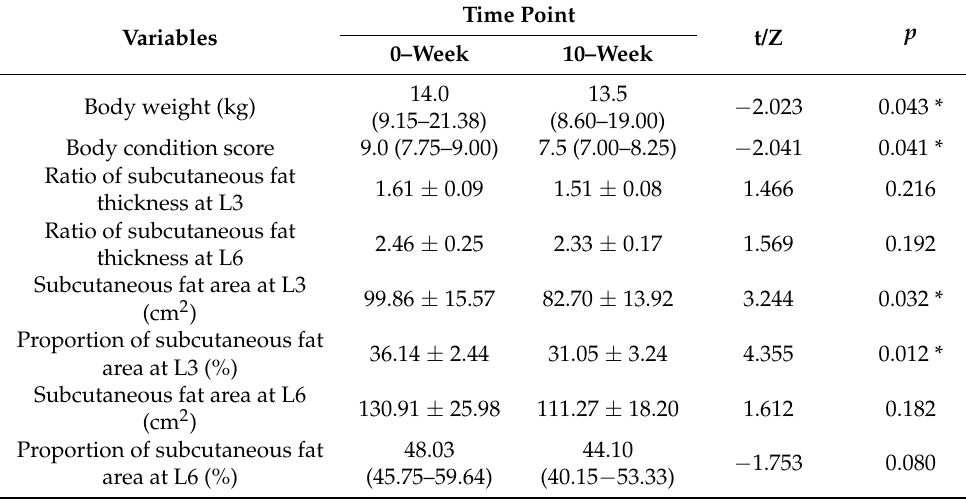
Table 3. Comparison of obesity variables between 0-week and 10-week.